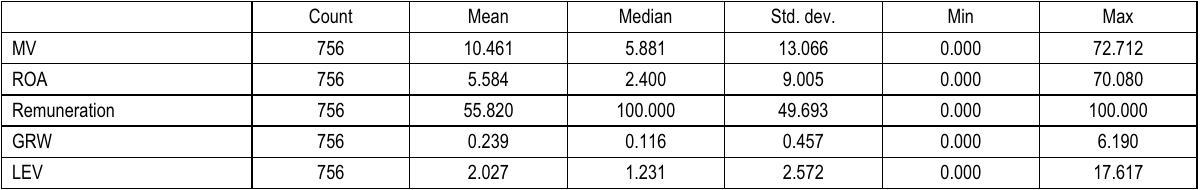
Table 3. Descriptive statistics for all the